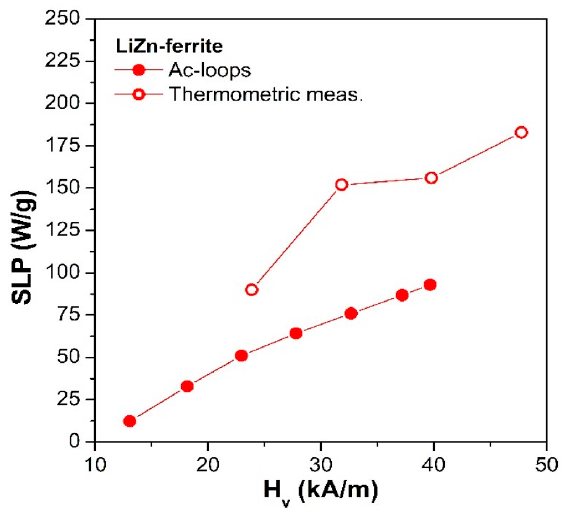
Figure 5. SLP values for the LiZn sample as a function of the vertex field obtained by: ac-hysteresis loops areas (full red dots) at the operation frequency of 69 kHz and the thermometric measurements (empty red dots) at the operation frequency of 100 kHz.